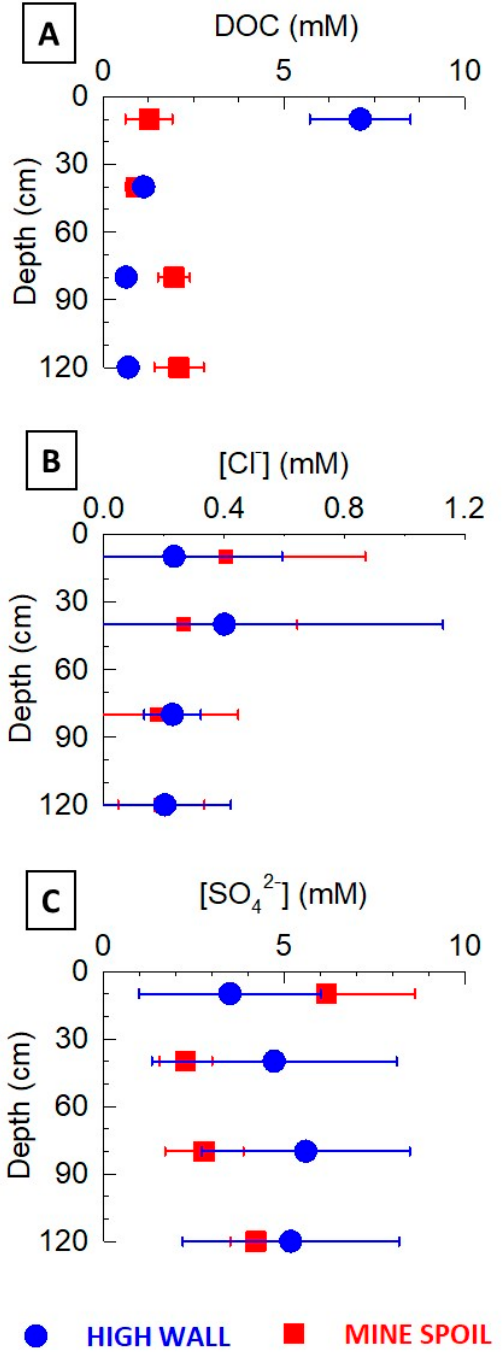
Figure 7. Average concentrations for ( A ) dissolved organic carbon (DOC), ( B ) chloride, and ( C ) sulfate collected from lysimeters installed in high wall soils (blue circles, left) and mine spoil soils (red squares, center) over the sampling season for lysimeters installed at 10, 40, 80, and 120 cm. Errors represent one standard deviation of the averaged values over the sampling period.